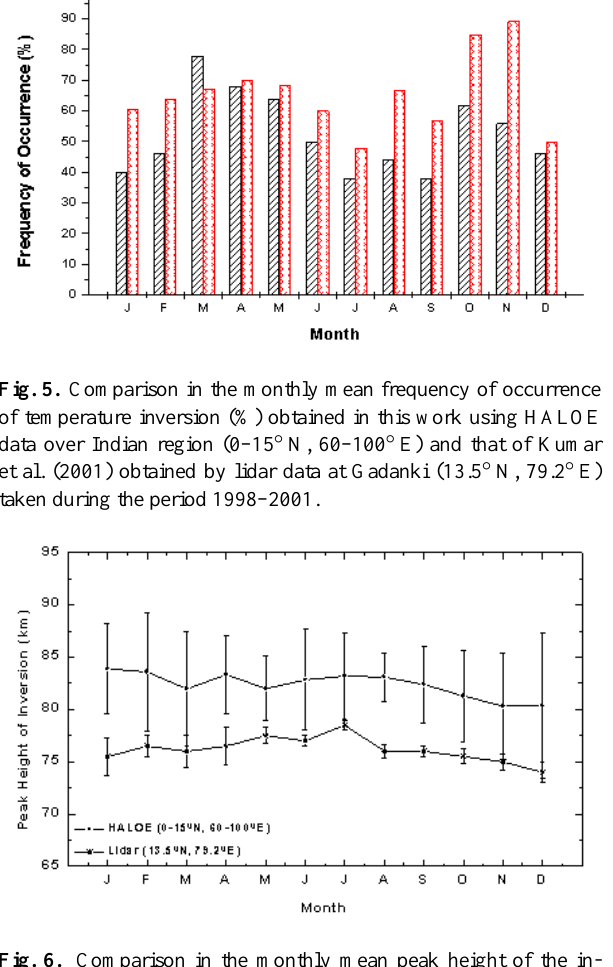
Fig. 6. Comparison in the monthly mean peak height of the in- version layer in km as obtained in this work using HALOE data over the Indian region (0–15 ◦ N, 60–100 ◦ E) and that of Kumar et al. (2001) obtained by lidar data at Gadanki (13.5 ◦ N, 79.2 ◦ E) taken during the period 1998–2001.